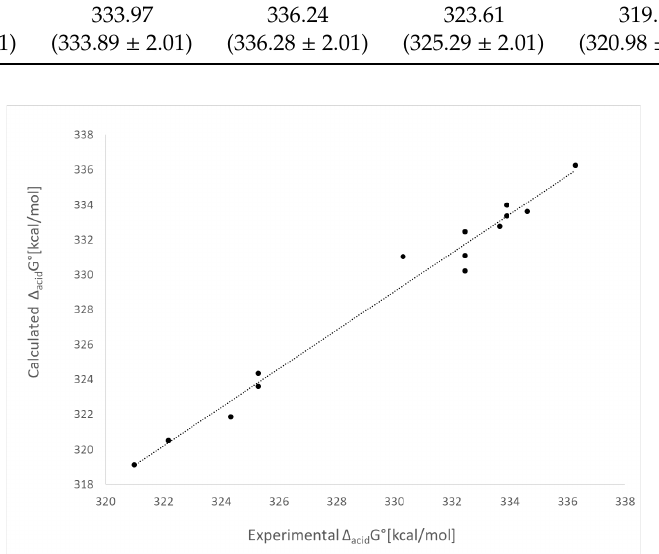
Figure 2. Calculated ∆ acid G ◦ vs experimental ∆ acid G ◦ values for a set of substituted benzoic acids. Gas phase acidity in kcal / mol, R 2 =